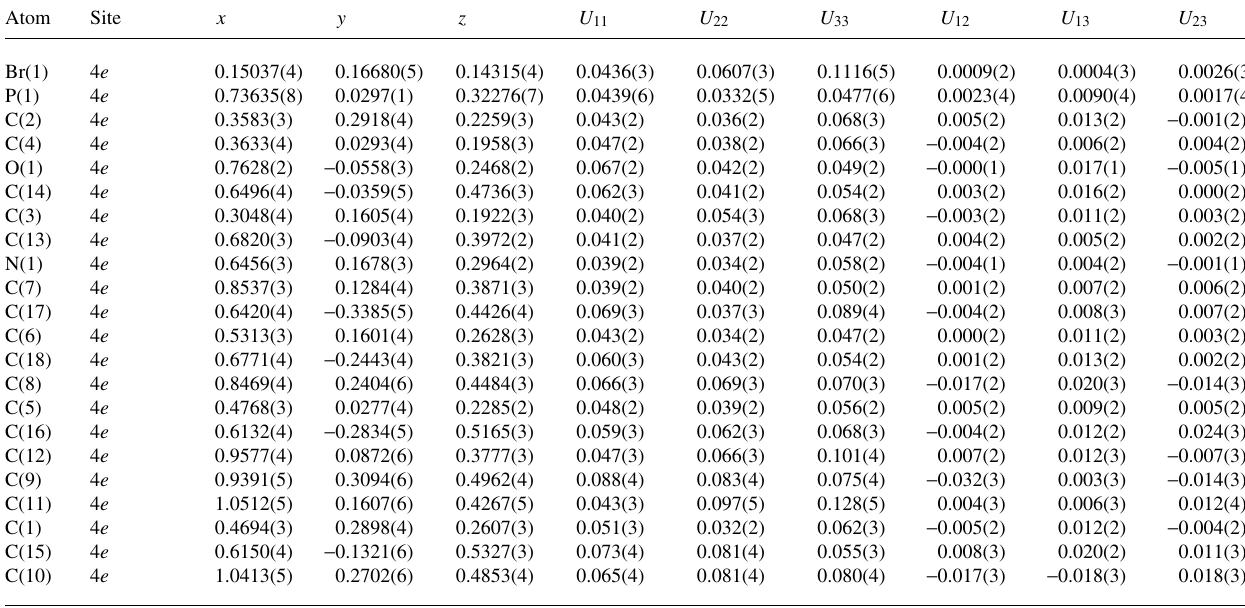
Table 3. Atomic coordinates and displacement parameters (in Å 2 ) .